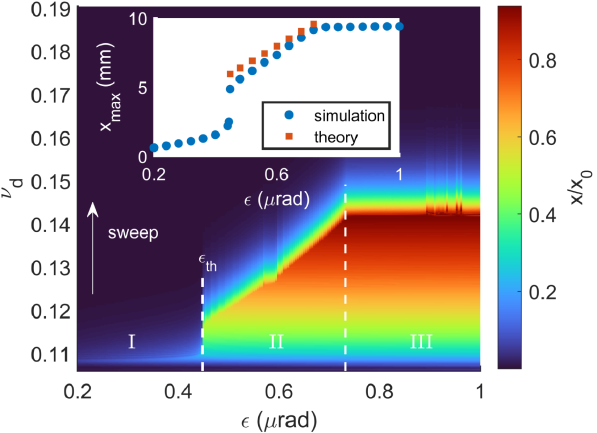
FIG. 5. Beam oscillation amplitudes ( x=x 0 , with x 0 ¼ 10 mm) for the SPEAR3 model as a function of drive amplitude, ϵ , and drive tune, ν d . The dashed line labeled by ϵ indicates the drive th amplitude threshold. Inset plot: Comparison of the maximum beam oscillation amplitudes between simulation and theory in region